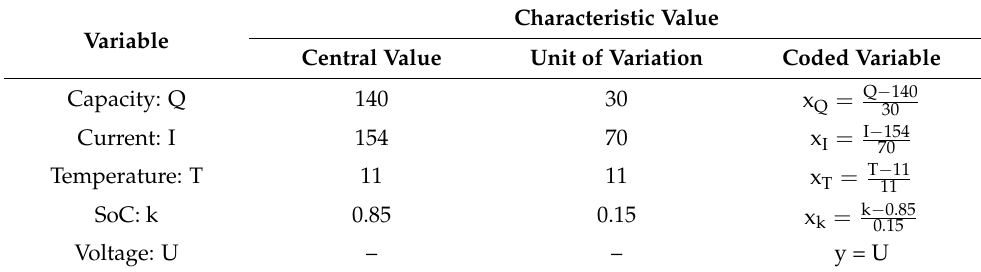
Table 1. Variables’ coding results.